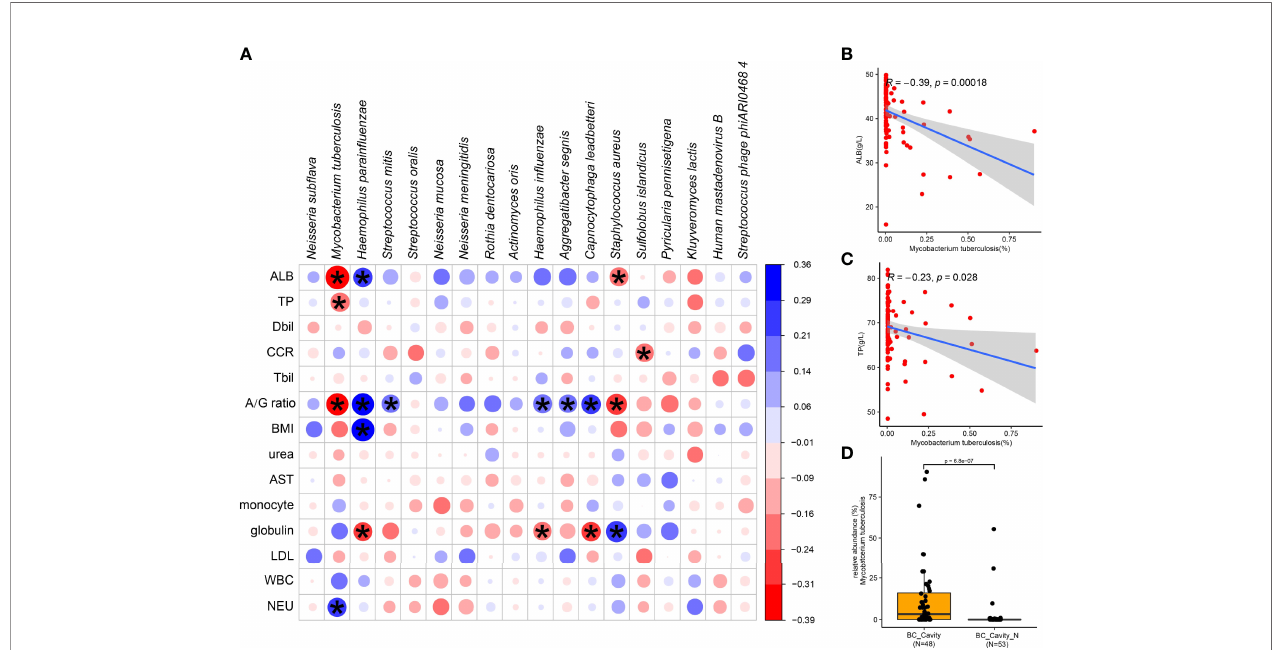
FIGURE 4 | Speci fi c microbial signatures are associated with the clinical data. The heat map shows the Spearman correlation between microbial species with clinical data (A) . Red values indicate species were negatively correlated with clinical data, while blue ones indicate the species were positively correlated with clinical data. Signi fi cant associations (adjusted p < 05) are indicated by asterisk. Spearman ’ s test showed that M. tuberculosis was negatively correlated with albumin (B) and total protein (C) . In the BC patients, the relative abundance of M. tuberculosis in those with cavity was signi fi cantly higher than in those without cavity (D) . ALB, albumin; TP, total protein; Dbil, direct bilirubin; Tbil, total bilirubin; A/G ratio, albumin/globulin ratio; BMI, body mass index; AST, aspartate transferase; LDL, low density lipoprotein; WBC, white blood cell; NEU, neutrophil; CCR,